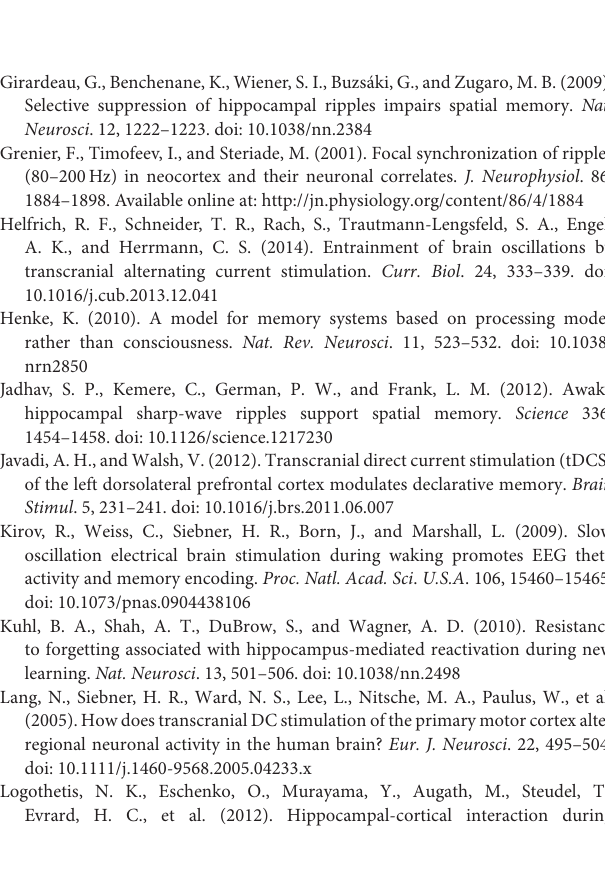
Supplementary Table 1 | Raw correct response data in the verbal learning